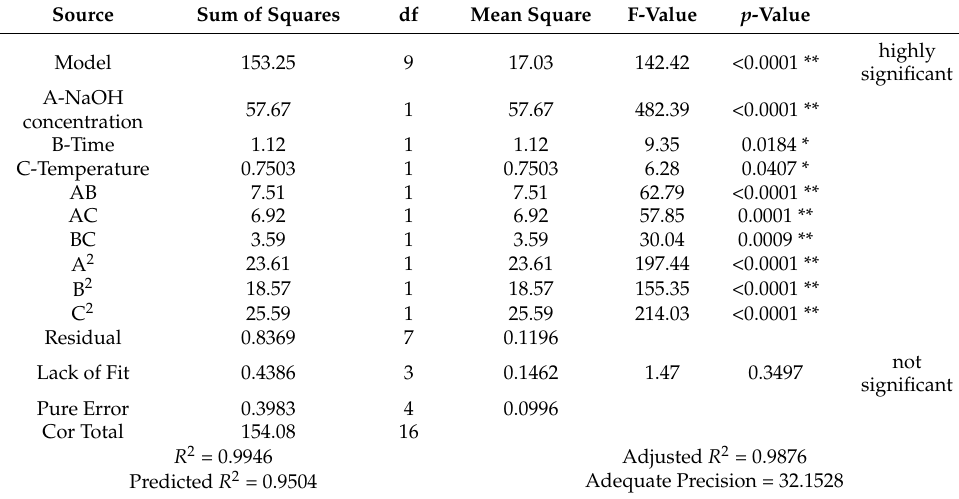
Table 5. ANOVA for coir fiber